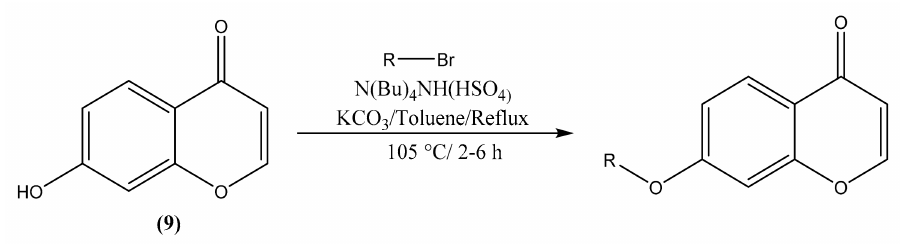
Scheme 1. Phase transfer catalysis reaction.